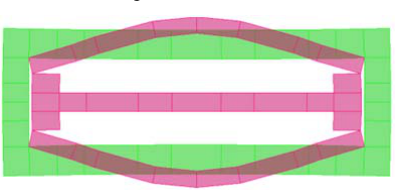
3 rd modal shape T=0.119 sec F= 8.38 Hz